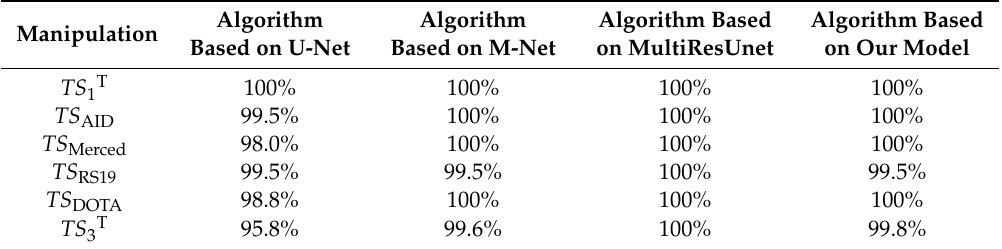
Table 3. Comparison of robustness test of digital watermarking embedding ( T h is set to 0.01). Algorithm Manipulation Based on U-Net